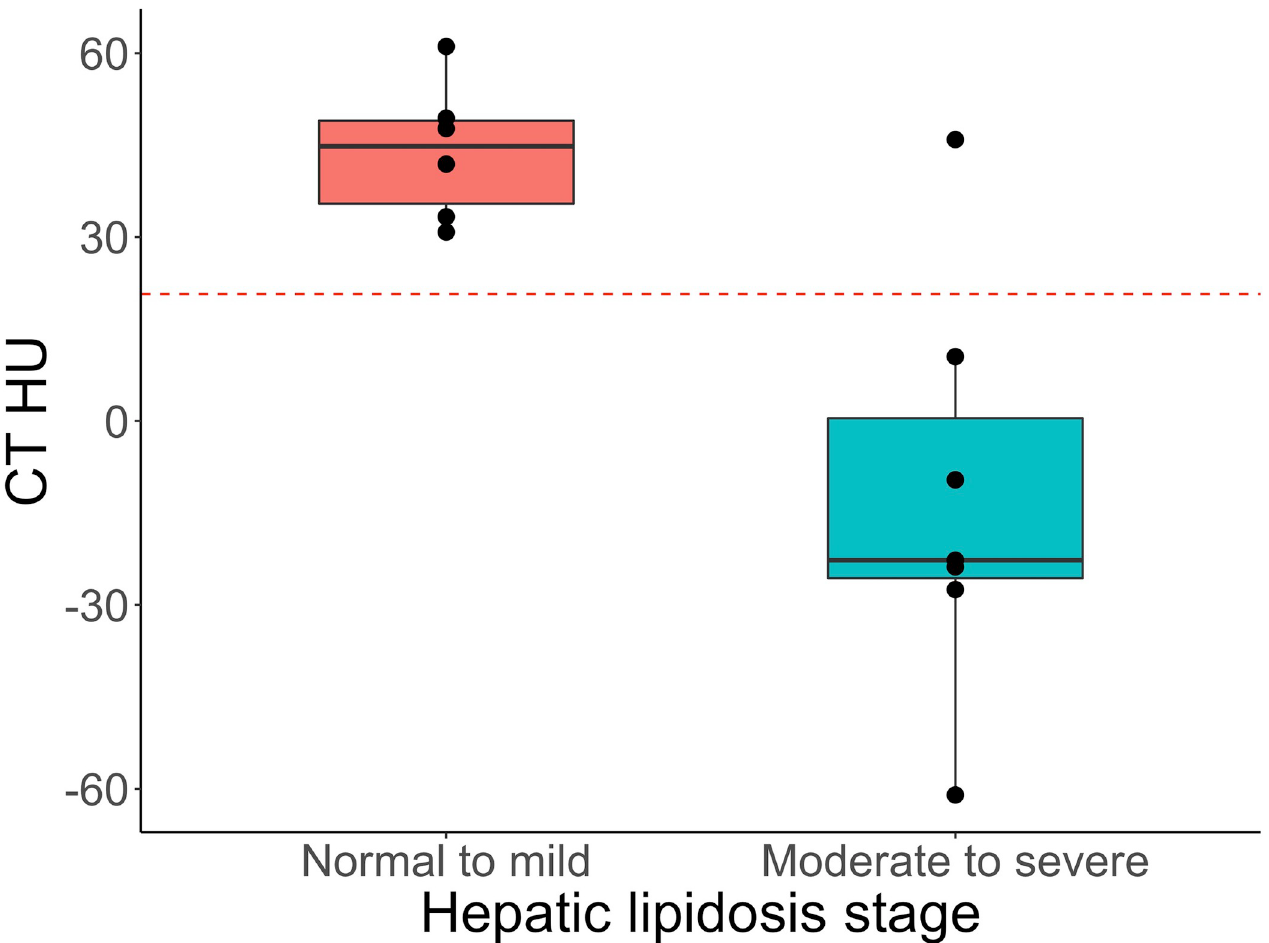
Fig 1. Computed tomography images (coronal multiplanar reconstruction views) of bearded dragons livers with different histologic classes based on an established grading system [30]. A) no-lipid, 48 Hounsfield Units (HU). B) Mild, 7HU. C) Severe, -36HU.